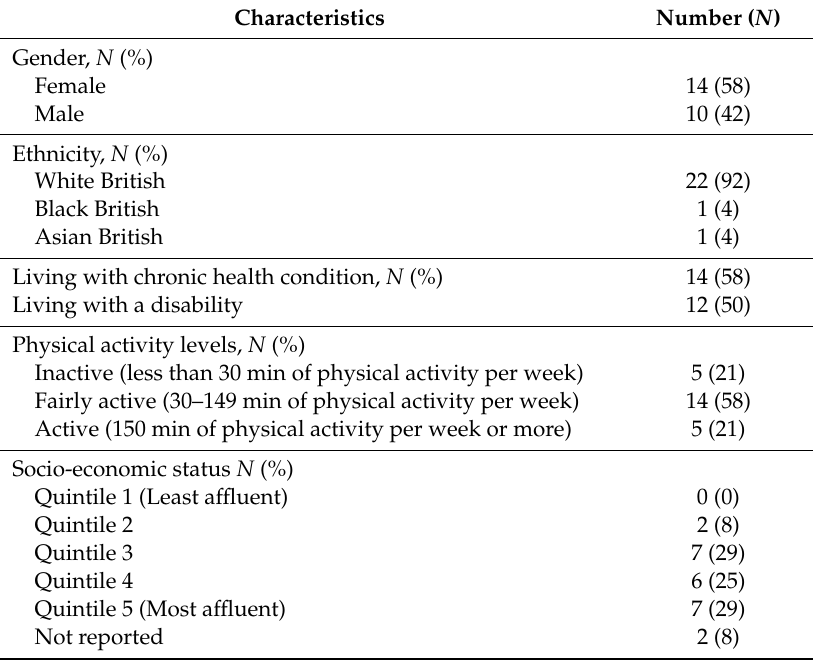
Table 2. Profile of end-user co-creators ( N =